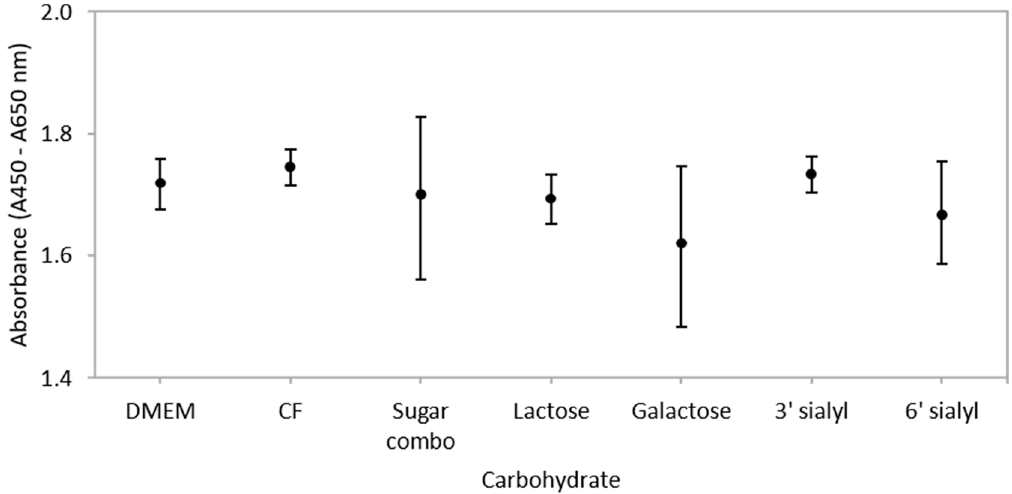
Figure 2. The metabolic activity of post-confluent (21 days post seeding) 90:10 Caco-2:HT29–MTX co-cultures after 3 h incubation with a carbohydrate fraction (CF) from caprine milk (CF; 4 mg/mL) and selected carbohydrates (at comparable concentrations to those found in the CF—refer to text) as determined from the Wst-1 assay. Values are means (±SEM) for three experiments (10 samples per treatment per experiment); n = 3. DMEM is the media control.